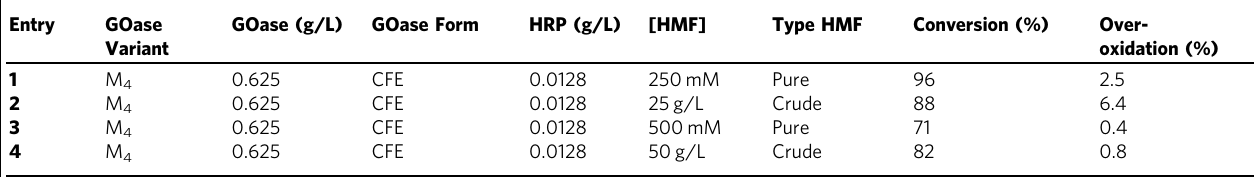
Data for reactions with puri fi ed enzyme provided in Supplementary Table 10. Conditions listed in the table highlight the main differences between samples, while those listed below the table apply to all entries unless otherwise stated.